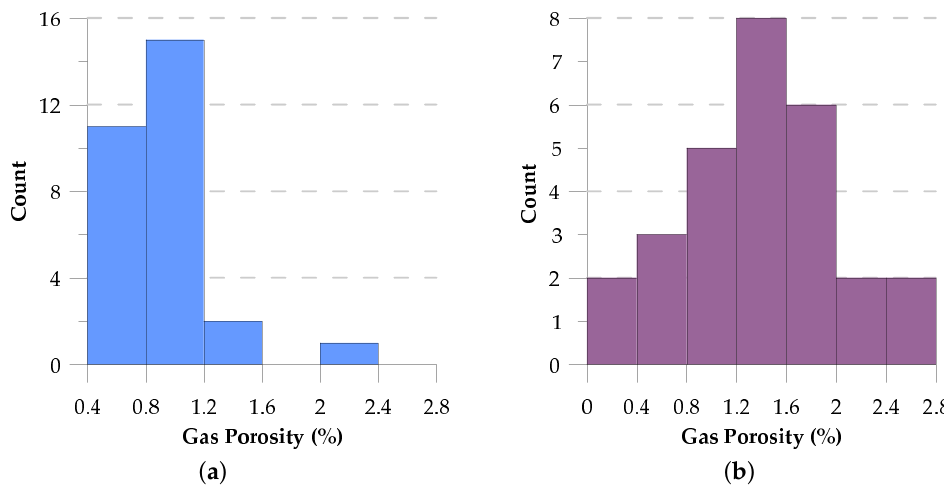
Figure 3. The porosity of received collection: ( a ) Ø100 × 200 mm whole cores; ( b ) Ø30 × 30 mm core plugs (courtesy of LUKOIL LLC, a priori data).